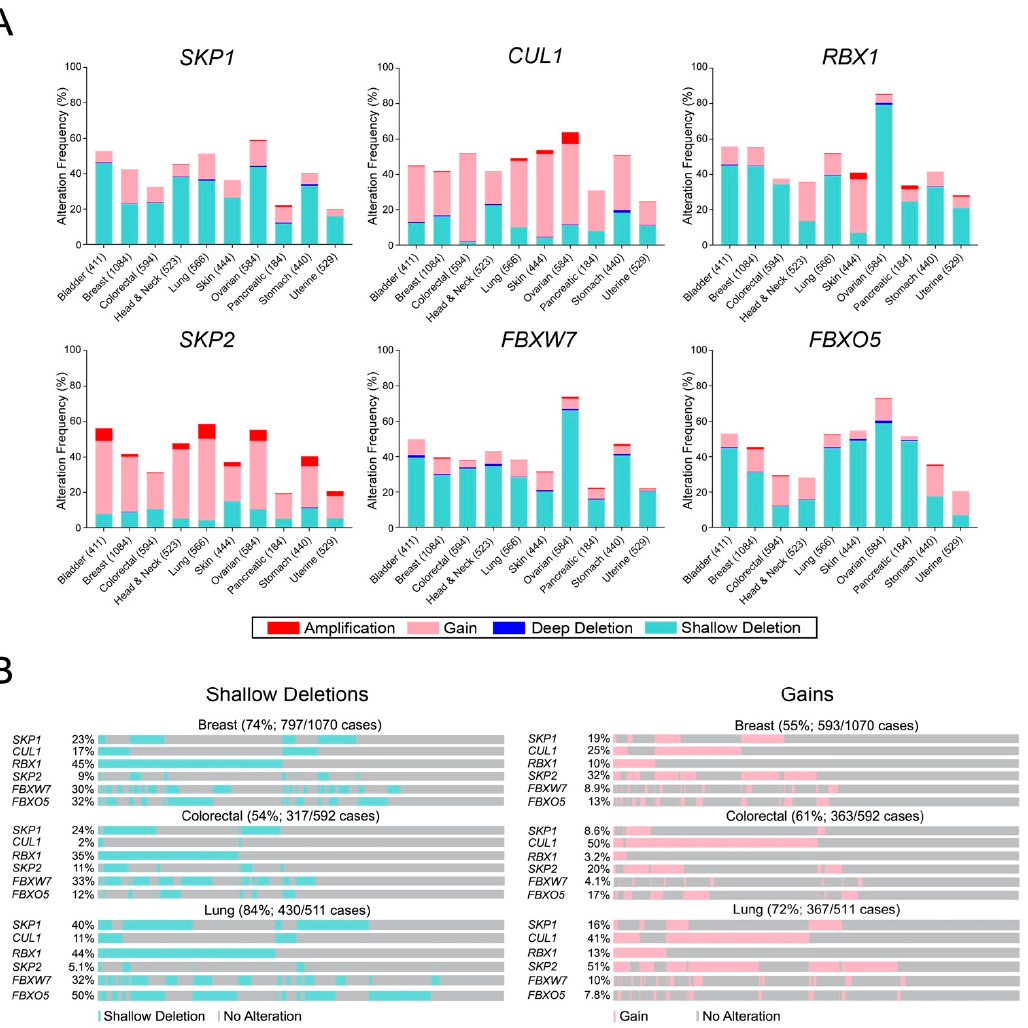
Figure 5. The frequency of gene copy number alterations of SCF complex members in 10 cancer types. ( A ) Bar graphs depicting the frequency of CNAs (deep deletions; shallow deletions; gains; amplifications) for six SCF complex member genes in 10 cancer types (Table S3). Cancer types are listed along the x -axis with the number of cases of each indicated in brackets. ( B ) OncoPrint data for breast, colorectal and lung cancer depicting the individual and cumulative frequencies for only shallow deletions (left) and gains (right) of six SCF complex member genes. Vertical alignments within a given cancer type identify samples from the same patient; patient-specific comparisons cannot be made between categories (i.e., shallow deletions versus gains).